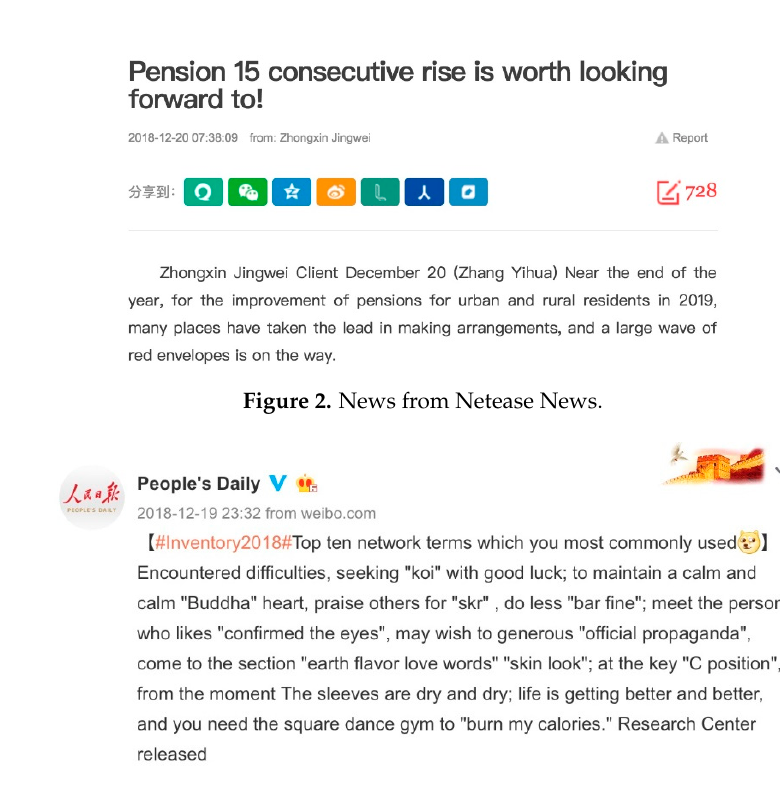
Figure 3. Weibo from Sina Figure 3 . Weibo from Sina Weibo. Figure 3 . Weibo from Sina Weibo.